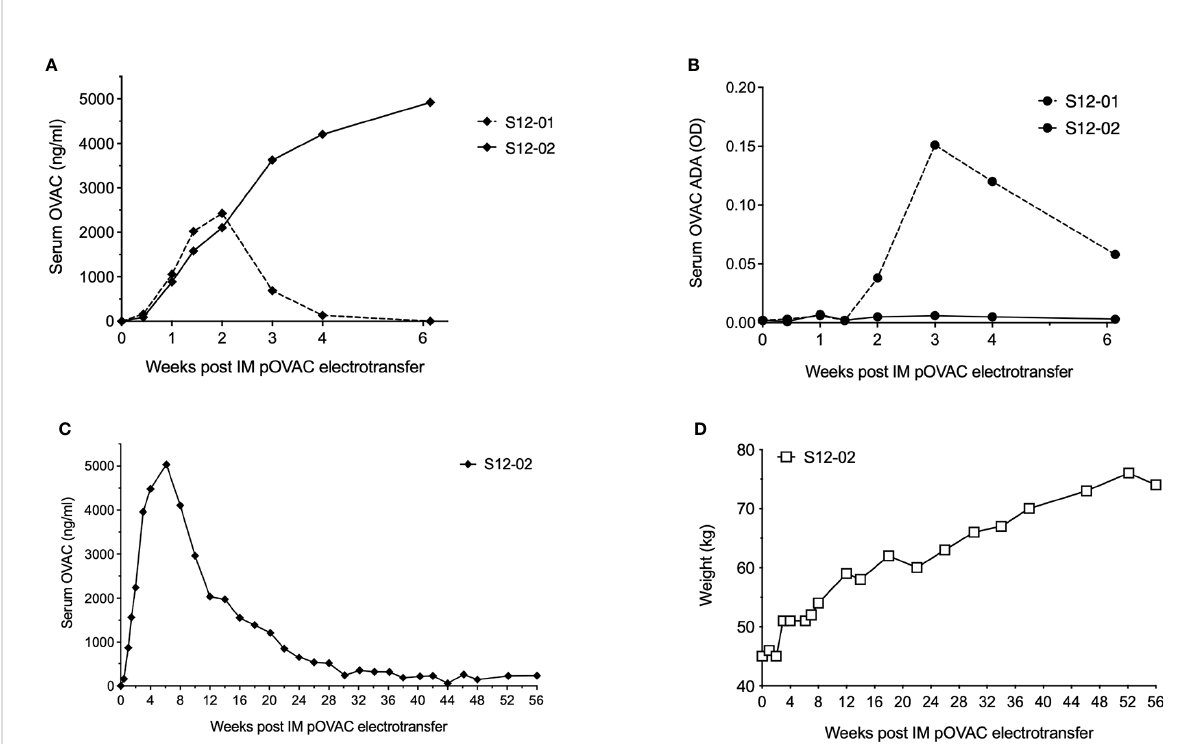
FIGURE 2 Readouts after administration of 12 mg pOVAC in sheep. (A) Serum OVAC concentrations of both sheep following IM EP in the fi rst six weeks. (B) Serum OVAC ADAs in both sheep. Values are shown in OD at a two-fold dilution. (C) Serum OVAC concentrations in sheep S012-02 for the full duration of the follow-up. (D) Body weight of sheep S12-02 during follow-up. ADA, anti-drug-antibodies; EP, electroporation; IM, intramuscular; OD, optical